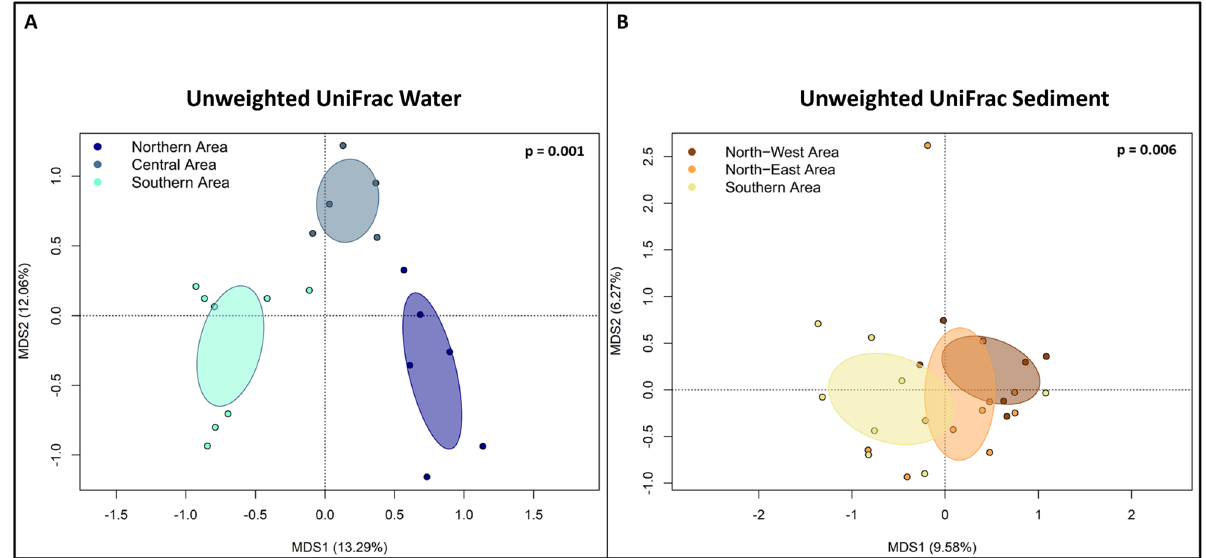
Figure 4. Beta diversity of the bacterial community of the water ( A ) and sediment ( B ) samples in the studied area. ( A ) PCoA based on unweighted UniFrac distances between pelagic microbiome of the 3 areas, samples are significantly separated (Adonis; p = 0.001). ( B ) PCoA based on unweighted UniFrac distances between sediment microbiome of the 3 areas, samples are significantly separated (Adonis; p =